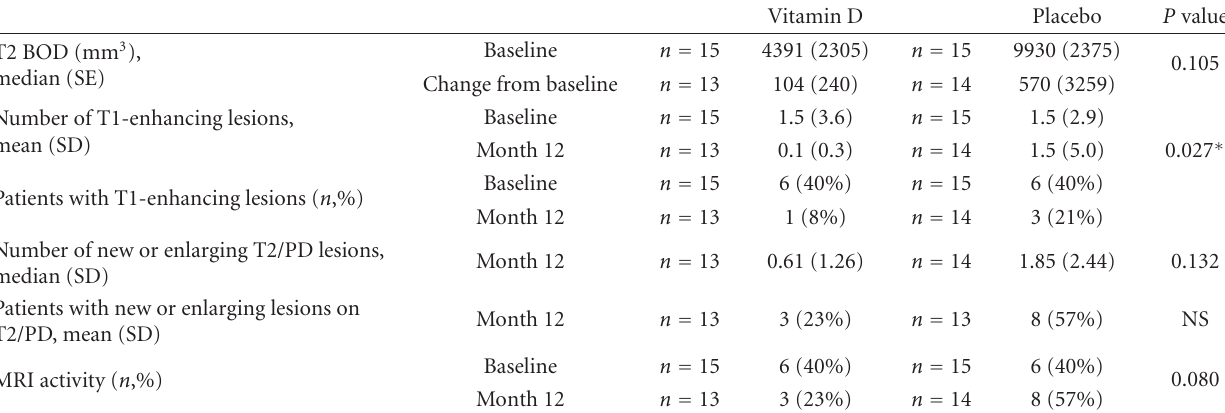
Table 2: MRI results in the vitamin D-and placebo-treated active subgroup patients. Vitamin D Placebo